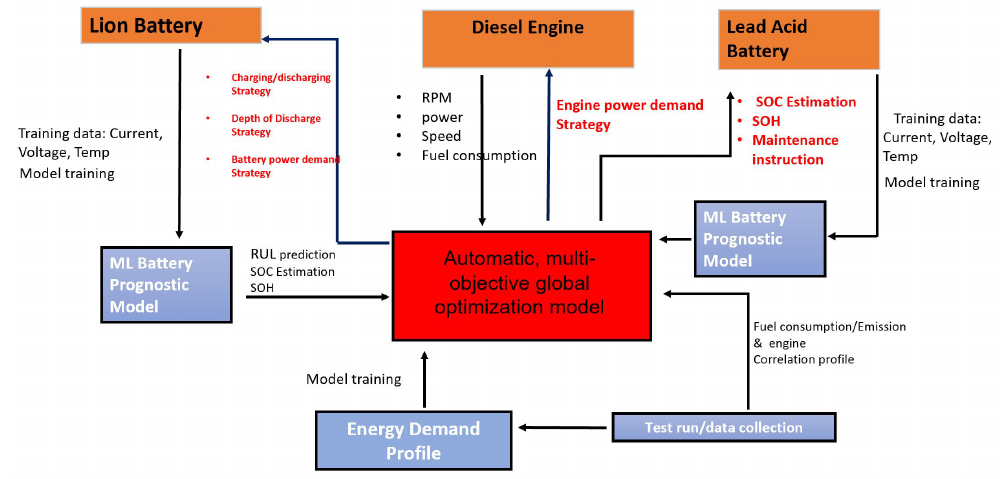
Figure 1. Overall system architecture and